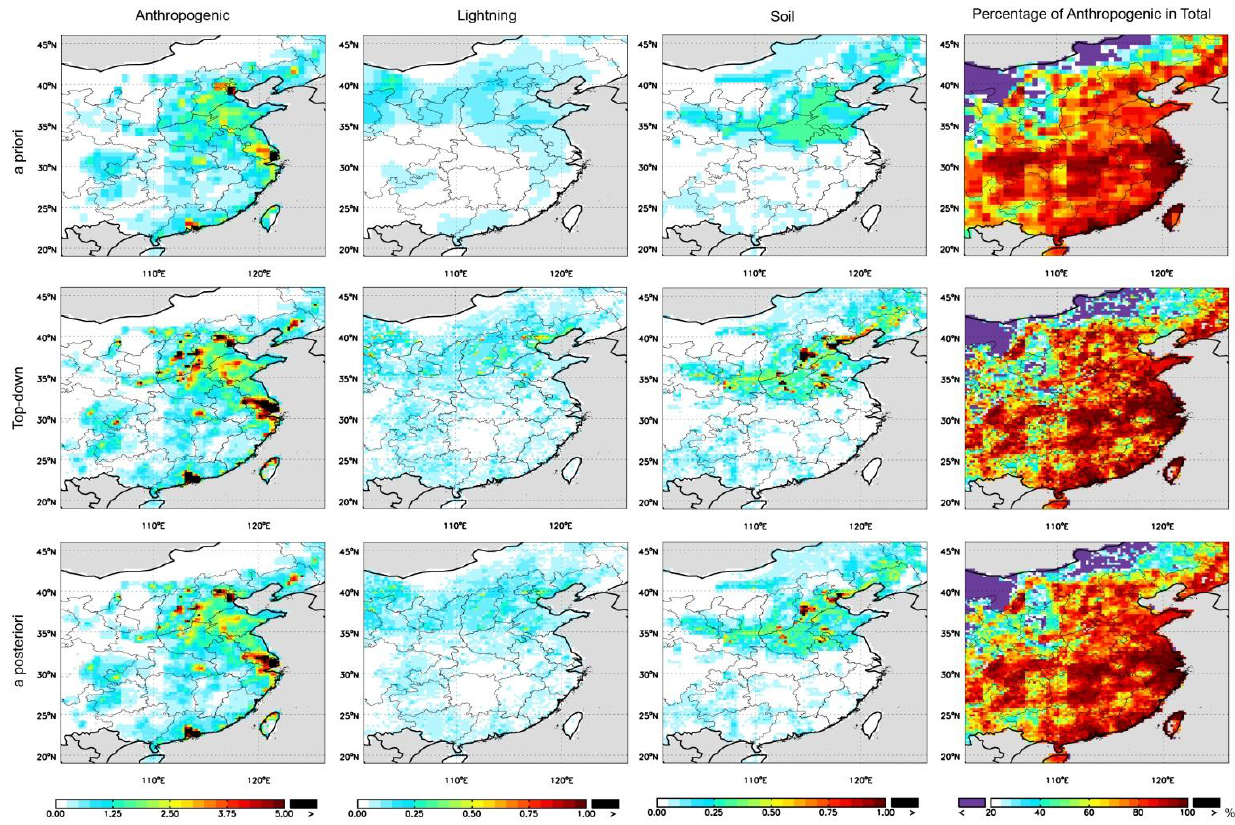
Fig. 9. The a priori, top-down and a posteriori estimates of anthropogenic, lightning and soil emissions of NO x (10 15 molec.cm − 2 h − 1 ) and the anthropogenic contributions (in percentage) to total emissions for July 2006 over East China. Areas outside the territory of China are shown in